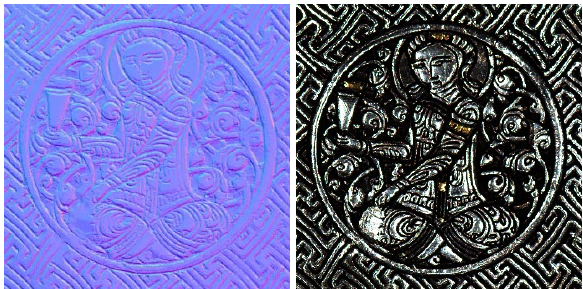
Figure 10. Cumulative distribution of sorted intensity values